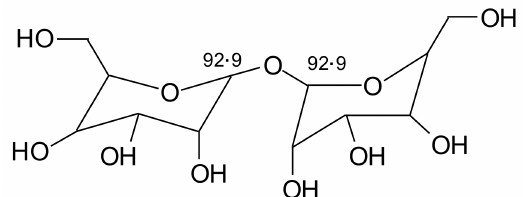
Figure 15. Example of two glucoses linked by a glucosidic bond formed by the elimination of CO 2 from two glucoses linked by a dimethyl carbonate. The peak is shown in Figure